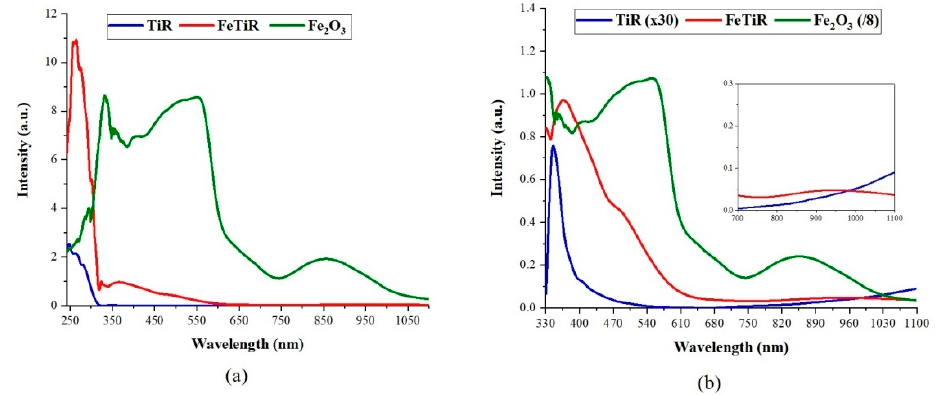
Figure 3. Comparative UV–Vis spectra are as follows: ( a ) Absorbance of TiR, FeTiR and Fe 2 O 3 registered in 250–1100 nm range. ( b ) Absorbance of TiR (multiplied 30 times), FeTiR and Fe 2 O 3 (decreased 8 times) recorded in 330–1100 nm range.